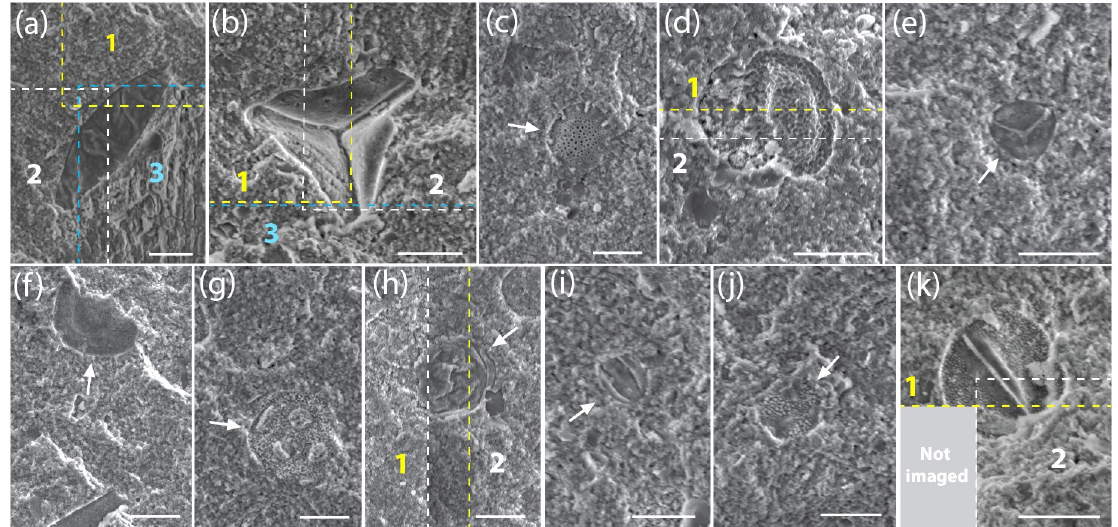
Fig 6. Pollen and spore types identified. ( a ) Fungal spore. ( b ) Fern spore. ( c ) Nothofagidites . ( d ) Gymnospermous saccate pollen. ( e ) Myrtaceae/Cupanieae pollen. ( f ) Triporate pollen. ( g ) Porate angiosperm pollen. ( h ) Araucariaceae, gymnosperm pollen. ( i ) Angiosperm col (por)ate pollen; Quintinia . ( j ) Angiosperm colporate pollen; Margocolporites vanwijhei . ( k ) Angiosperm colpate pollen. Dashed lines indicate the overlap/stitching between neighbouring images. Scale bars, 15 μ m. Arrows indicate the position of microfossils. Images have been adjusted slightly to improve contrast. Images appearing as they were viewed by volunteers can be found in S3